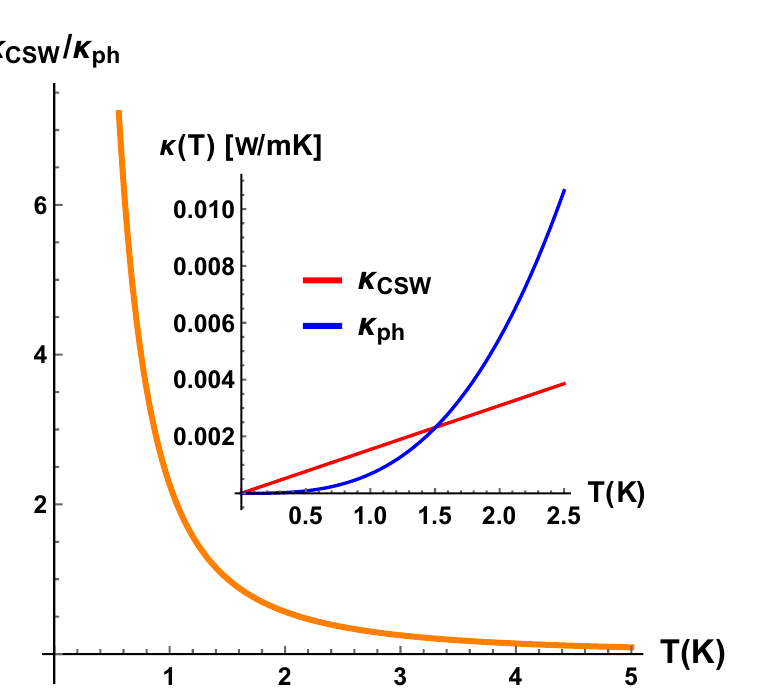
Figure 2: Rate of the CSW and the acoustic phonon contribution to the longitudinal thermal conductivities along the axis of the twist. The two contributions are shown in the inset. At temperatures below 1.5 K the CSW contribution is